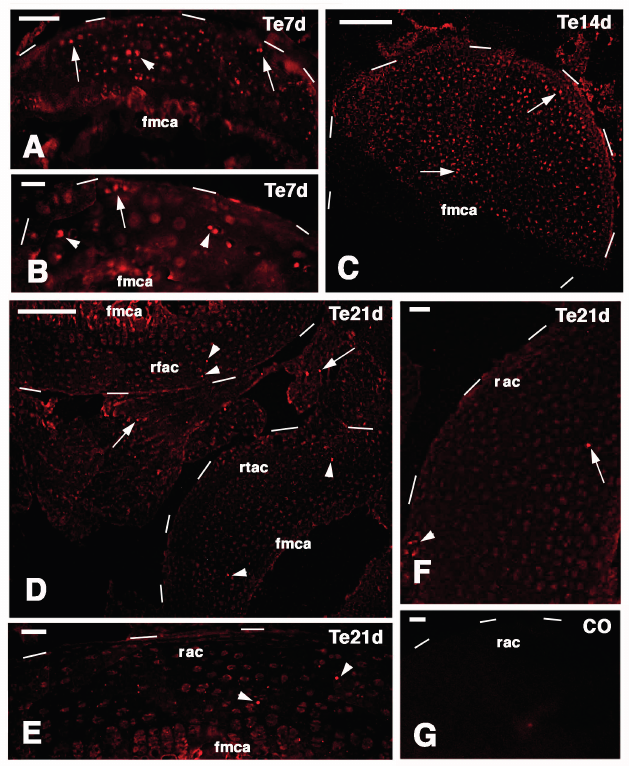
Figure 8. TRITC immunolabeling for a telomerase-1 components (Te) in the regenerating epiphyses (dashes outline their surfaces). ( A ) At seven days few labeled cells are seen within the new cartilage (arrowhead) and along the surface (arrows) of a tibia. Bar, 50 µm; ( B ) other mass of cartilaginous tissue in a tibia at seven days post-injury showing labeled cells on the surface (arrow) and inside the cartilaginous tissue (arrowheads). Bar, 25 µm; ( C ) sparse intensely labeled cells within (arrowhead) and near the surface (arrow) of a cartilaginous epiphyses 14 days after injury. Bar, 100 µm; ( D ) Very sparse labeled cells are seen within the femur (top arrowheads) and tibia (bottom arrowheads) articular cartilages 21 days after injury. Few labeled cells (arrows) are also seen in the meniscus. Bar, 100 µm; ( E ) detail showing two labeled cells (nuclei, arrowheads) within the regenerated cartilage at 21 days. Bar, 25 µm; ( F ) other detail on labeled cells (arrow inside the cartilage; arrowhead near the surface) at 21 days post-injury. Bar, 25 µm; ( G ) control section. Bar, 25 µm. Legends: fmca, forming metaphyseal cartilage (plate); rfac, regenerated femur articular cartilage; rac, regenerated articular cartilage; rtac, regenerated tibia articular